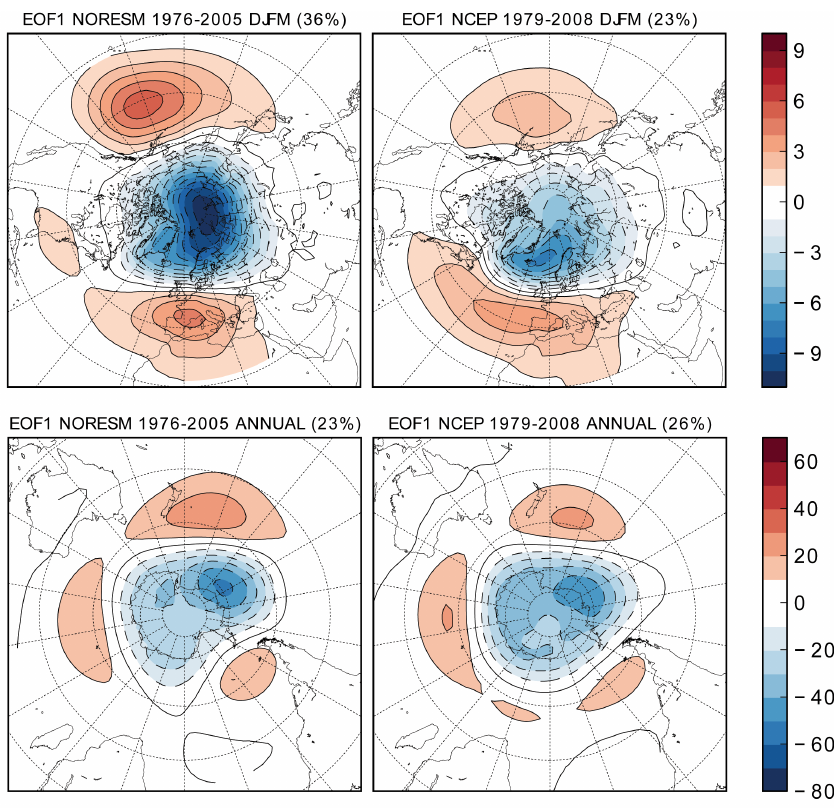
Fig. 21. The leading EOF of winter (DJFM) monthly mean SLP anomalies (hPa) over the Northern Hemisphere (20–90 ◦ N) in Historical1 (top left panel) and NCEP-2 (top right). The leading EOF of monthly mean 850hPa geopotential height anomalies (m) over the Southern Hemisphere (90–20 ◦ S) for Historical1 (bottom left panel) and NCEP-2 (bottom right). Prior to the EOF analysis the data were weighted by the square root of the cosine of latitude so that equal areas are afforded equal weight. The principal components (PCs) were scaled to unit standard deviation and projected on the original (not area-weighted) data to obtain corresponding EOFs. The leading EOFs shown are associated with a one standard deviation change in the corresponding PCs (index time series).